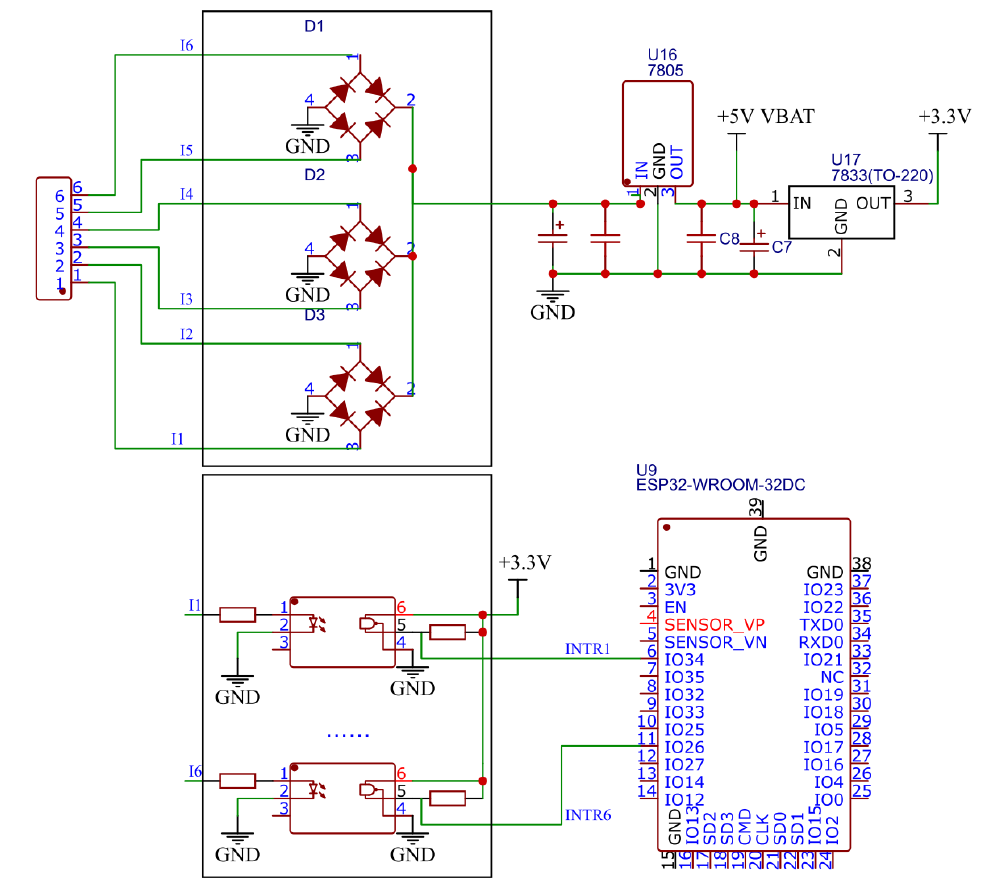
Figure 11. Schematic diagram of the Receiver. The upper part shows the multi-phase bridge followed by two linear regulators, and is used to provide power to the robot; in the lower part, the signals coming from the contact pins (2 out of 6 are shown in the figure) are photocoupled and passed to the receiver microcontroller, which acquires them in order to compute the robot